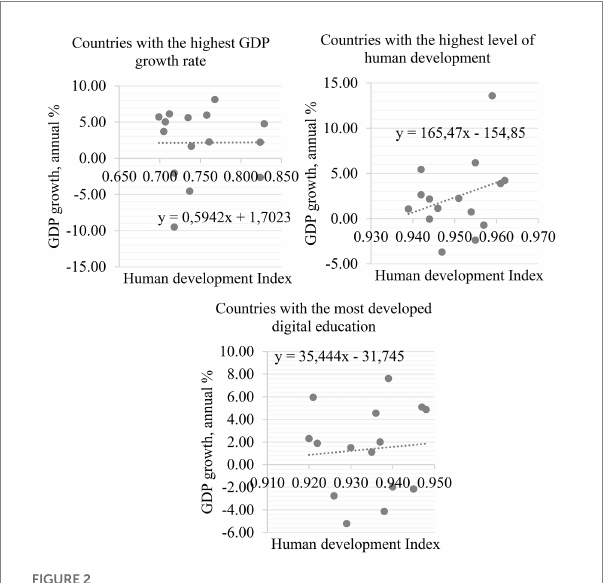
FIGURE 2 Regression curves. Calculated and constructed by the authors.